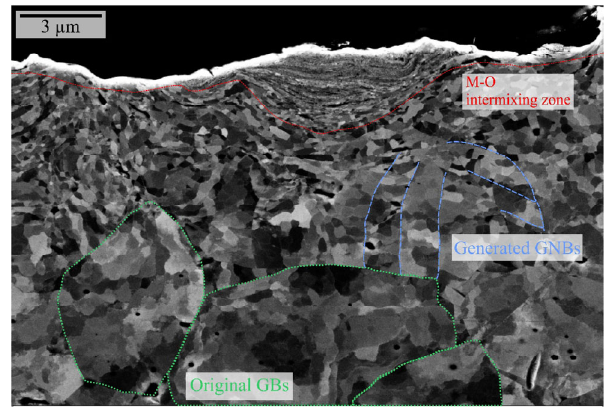
Fig. 9 BSE image showing the development of sub-grains inside the initial grains of the coarse-grained sample after 5,000 sliding cycles at 5 N.